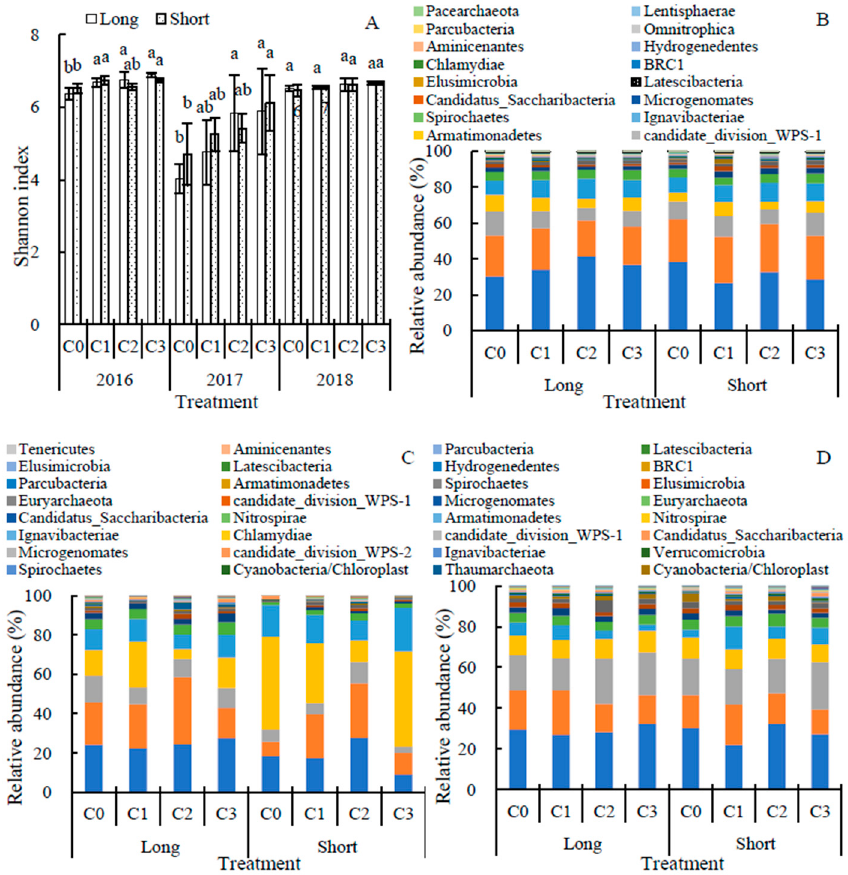
Figure 5. The effect of long- and short-term, increasing biochar application rates [0 (C0), 10 (C1), 20 (C2) and 40 (C3) t ha − 1 ] on changes of the ( A ) Shannon index and soil microbial diversity (( B ): 2016; ( C ): 2017; ( D ): 2018). Different lower-case letters above error bars indicate significant differences between the biochar treatments in either the short- or long-term for a given year ( p < 0.05, LSD post-hoc test). The error bars represent standard deviation of the mean ( n = 3).